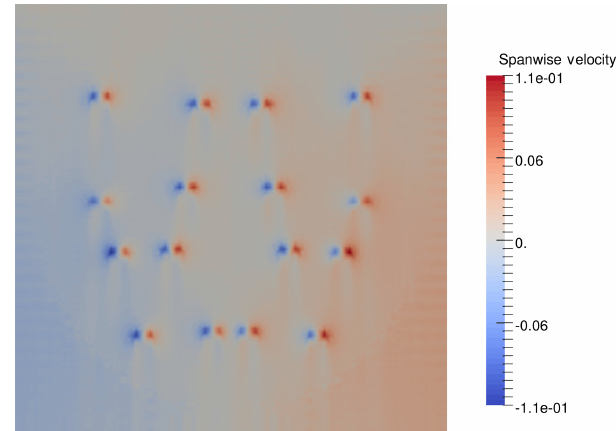
Figure 7. Spanwise velocities produced by the optimized layout found in the five-inflow-direction case shown in Fig. 6d. The span- wise velocity is normalized by the hub-height inflow velocity, indi- cating strong curvature at the rotor and a slight overall deflection of the flow away from the center of the wind